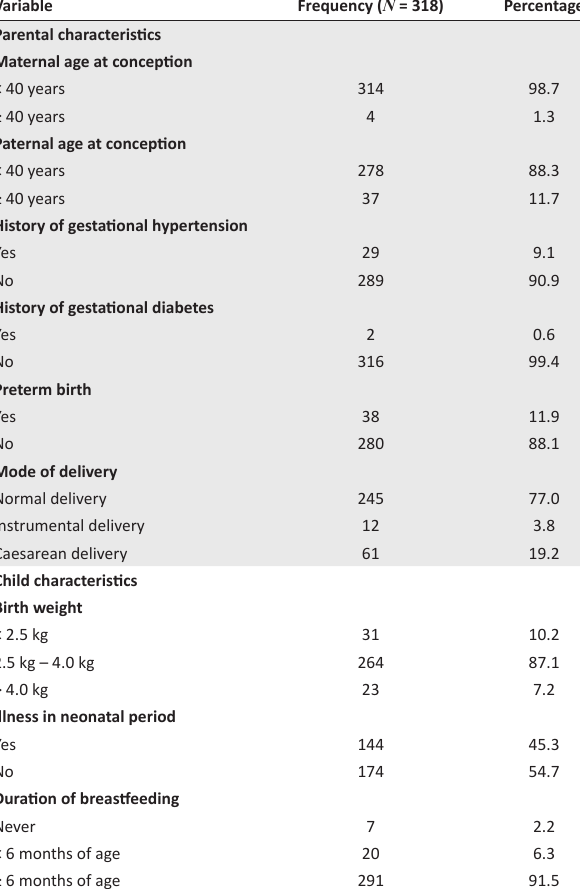
TABLE 2: Prenatal, birth and postnatal characteristics of the participants. Variable